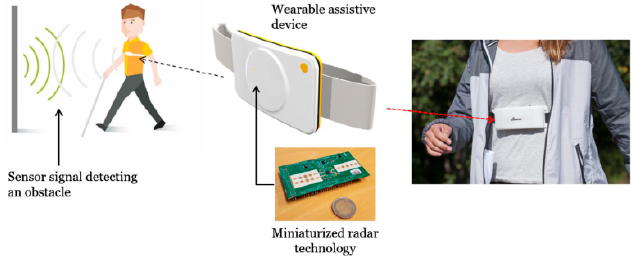
Figure 5. Operating principle of the system and picture of the device [20].